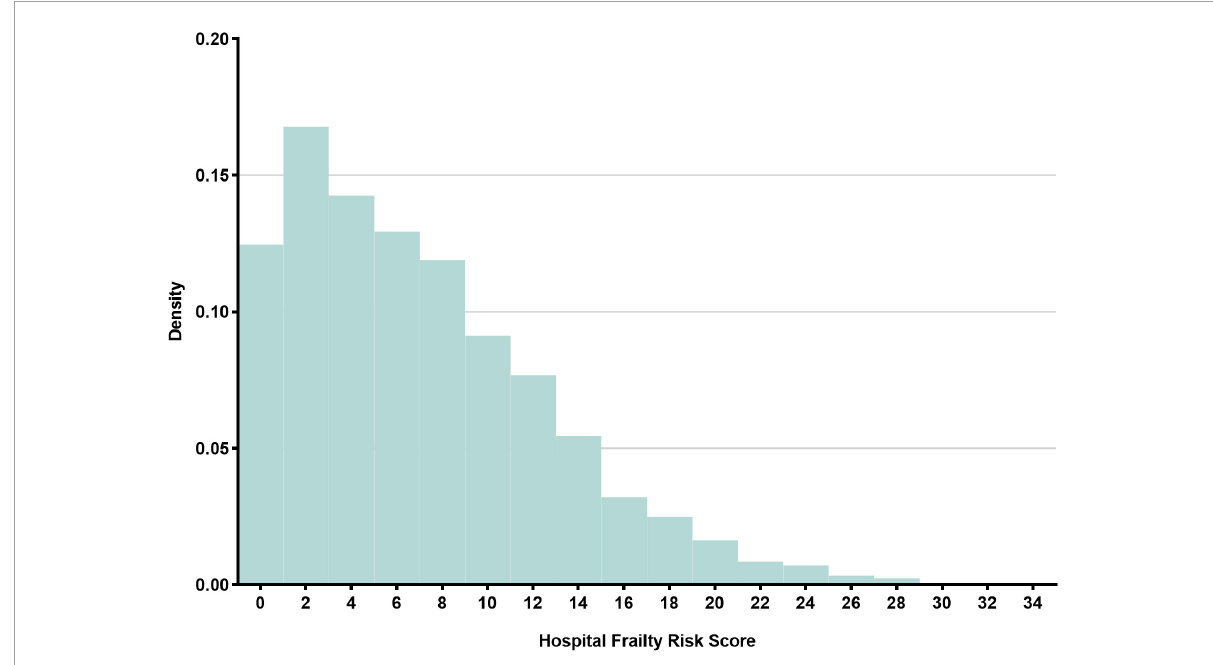
FIGURE2 Histograms showing the distribution of the Hospital Frailty Risk Score